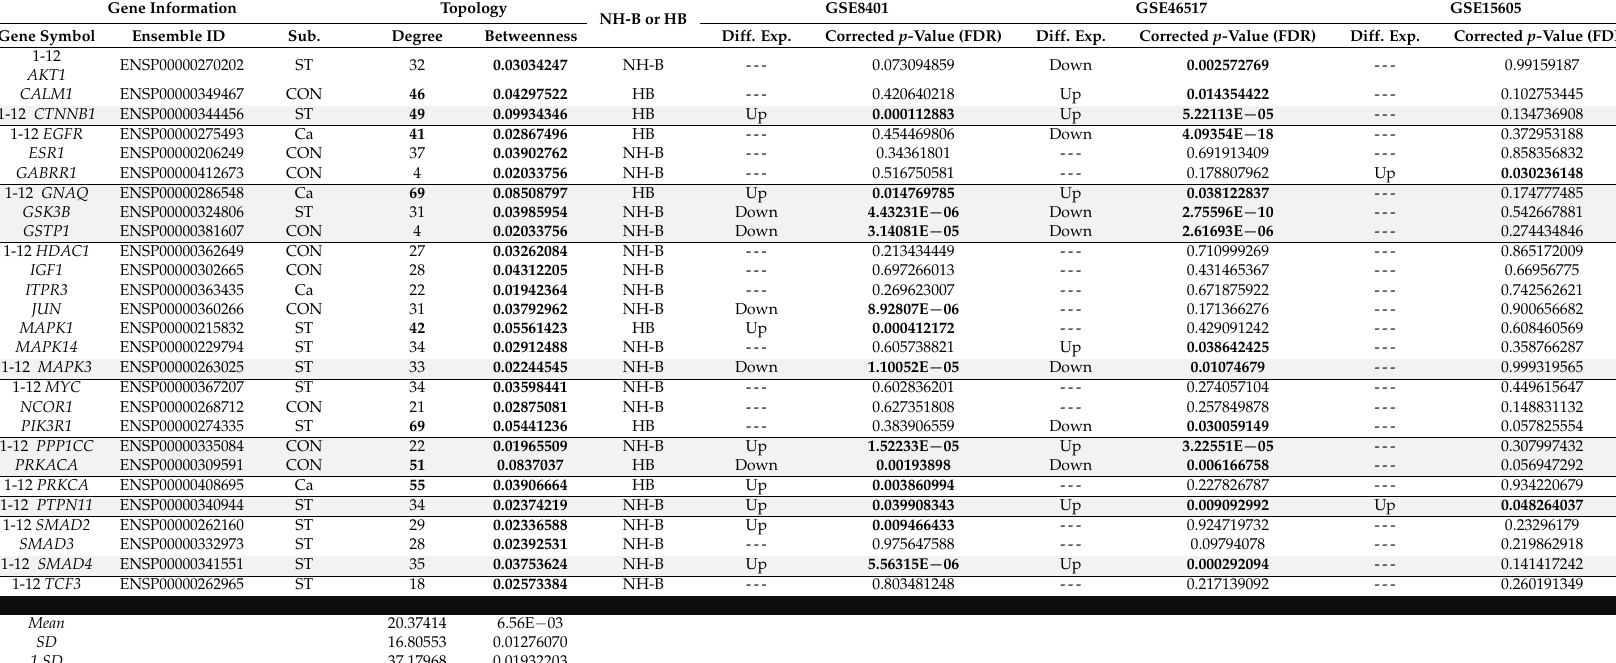
Table 1. Centrality values ( degree and betweenness ) for each node (gene/protein) within the stem cell pluripotency (map04550) and calcium signaling (map04020) interaction network model (“STEMCa” network). Differentially expressed genes within these members are listed. Centralities over the thresholds with values above one standard deviation of the mean (+1 SD) are in bold. Corrected p -values < 0.05 are considered significant for differentially expressed genes. Nodes identified as nonhub-bottlenecks (NH-Bs) and hub-bottlenecks (HBs) (based on degree and betweenness centralities), with values above +1 SD of the mean are represented as NH-Bs and HBs, respectively. “ST”, “Ca”, and “CON” represent “stem cell pluripotency”, “calcium signaling”, and “connector”, respectively. NH-Bs and HBs differentially expressed in at least two analyzed GSEs are in gray color. Only one gene ( PTPN11 , NH-B) was differentially expressed (upregulated) in the three analyzed GSEs. Table sorted by alphabetical order of gene